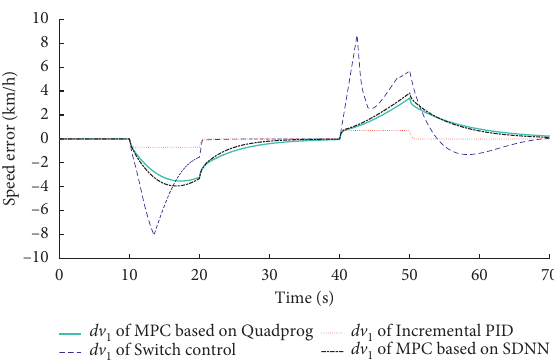
Figure 18: Speed errors of the LV and the FV of four